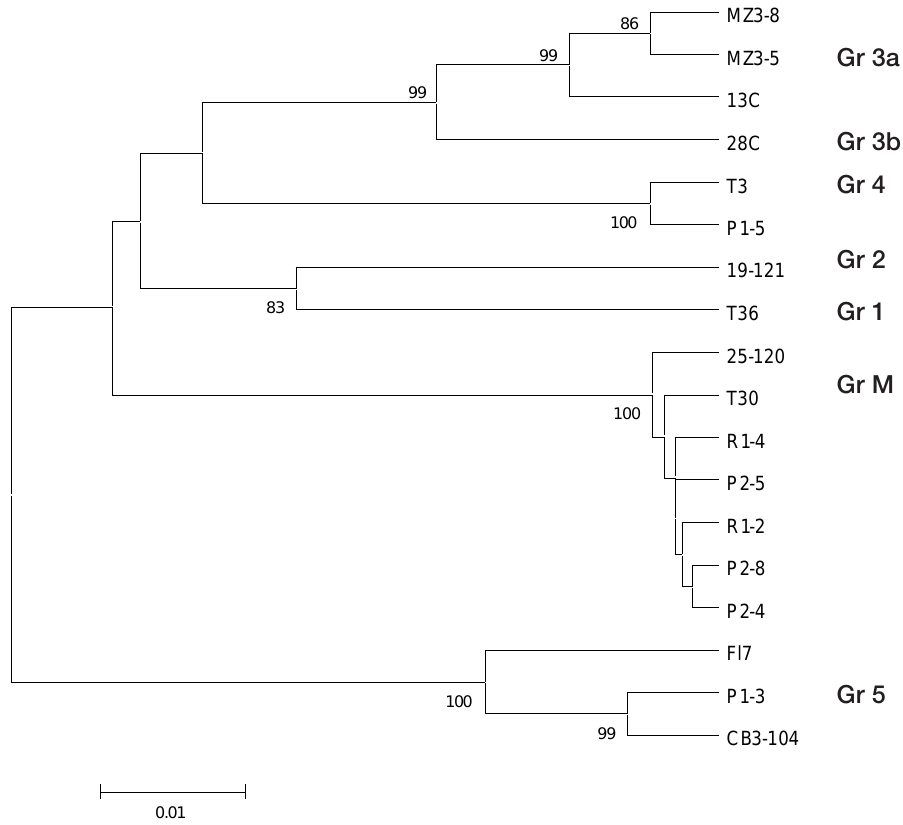
Fig. 3. Dendrogram showing the clustering pattern of the coat protein gene sequences as obtained by UPGMA. Groups mentioned in Zemzami et al . (2002) are shown on the